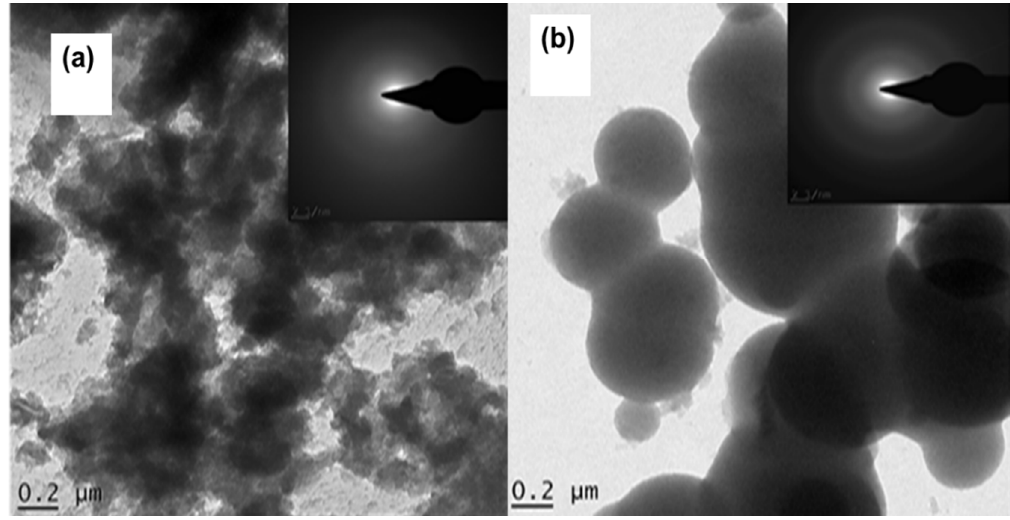
Figure 4. TEM images of ( a ) PABA and ( b ) the PABA/CoZIF composite; inset: selected area electron diffraction (SAED) images.